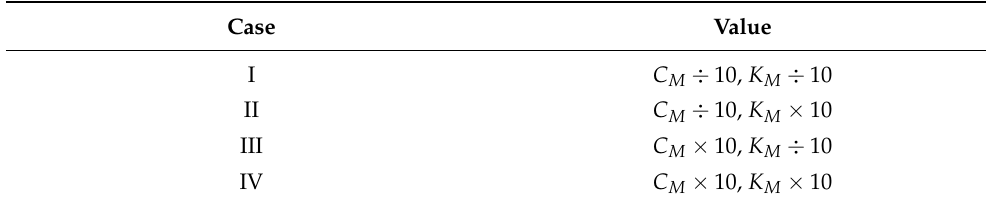
Table 2. Modified mechanical properties of vibration isolator.